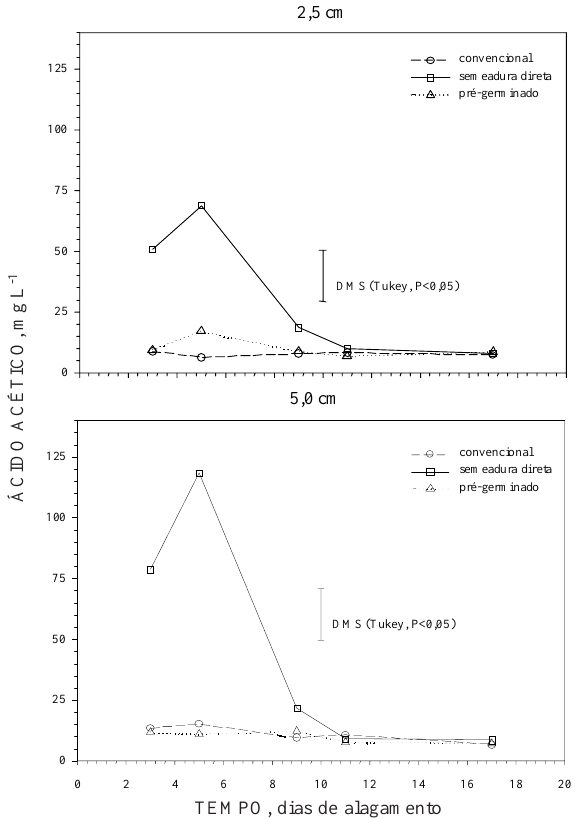
Figura 2. Concentração de ácido acético na solução de um Gleissolo, em duas profundidades (2,5 e 5,0 cm), em três sistemas de cultivo de arroz durante 17 dias de alagamento do